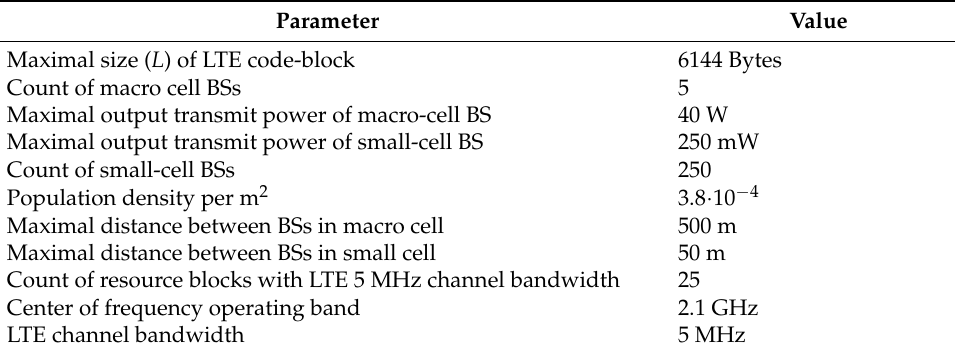
Table 1. Parameters in ns3 simulations.